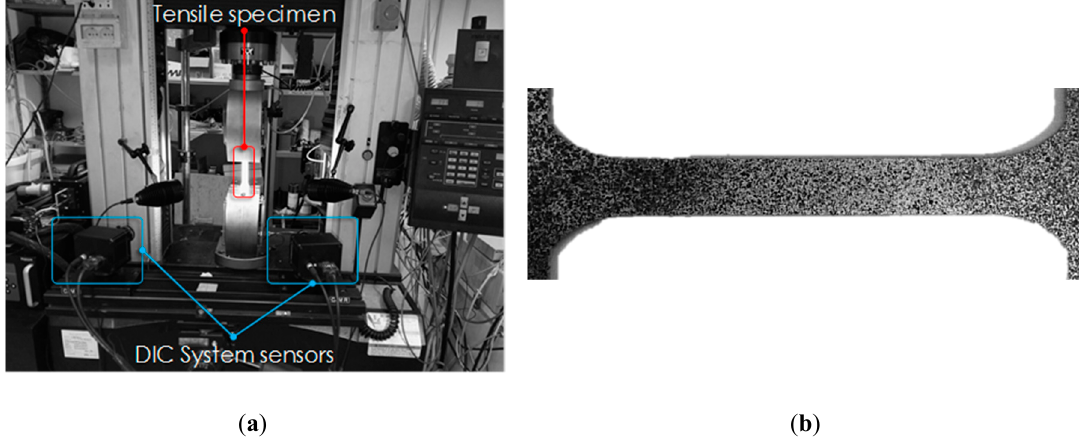
Figure 2. Tensile test: ( a ) experimental equipment, ( b ) detail of the speckled specimen gauge length.